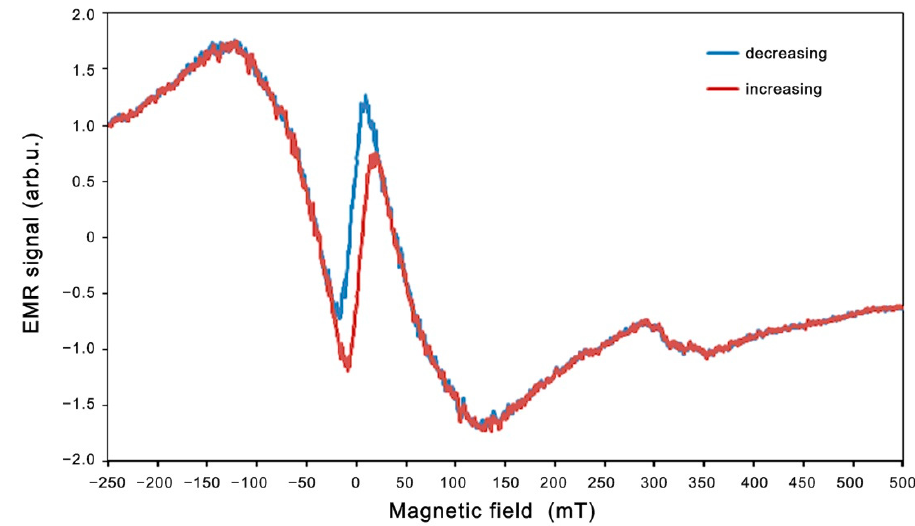
Figure 9. EMR spectrum recorded for an increasing (red) and decreasing (blue) magnetic field at